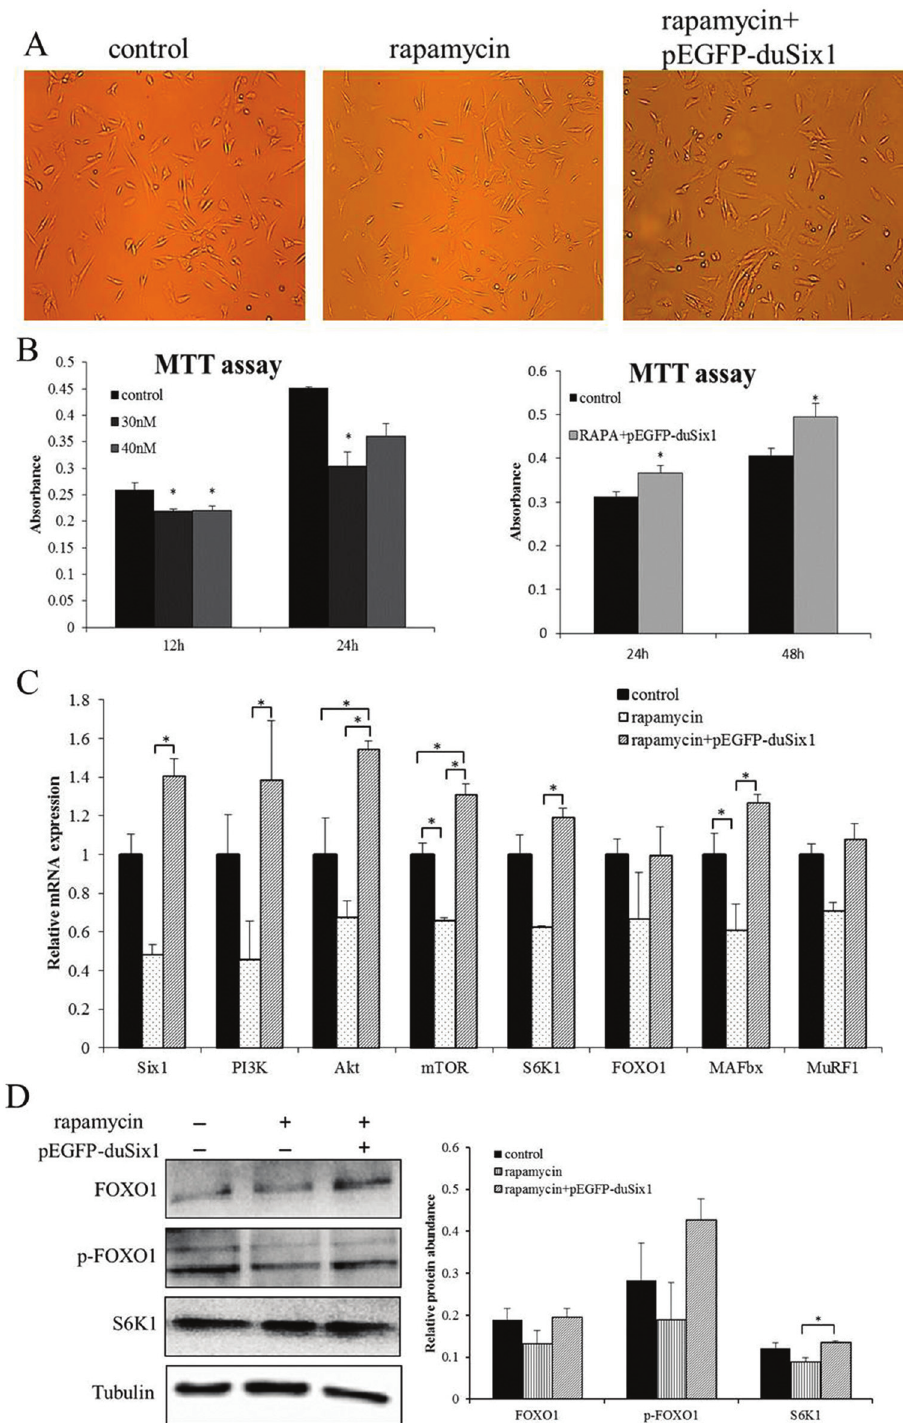
Figure 3 - Overexpression of Six1 can stimulate protein synthesis in rapamycin-treated duck myoblasts. A: Representative images of myoblasts for dif- ferent treatments groups, (a) control cells, (b) rapamycin treatment cells at 24 h, (c) Rapamycin treatment of cells for 24 h was followed by transfection with pEGFP-duSix1 for 48 h. B: Effects of different treatments on cell proliferation of duck myoblasts at different times. Cell proliferation was measured by MTT assay. Absorbance was measured at 570 nm, and data are presented as means (cid:6) SEM, n = 5 wells, *(P < 0.01). C: Relative expression levels of Six1 and key genes related to protein synthesis and degradation in duck myoblasts after different treatments. Duck (cid:2) -actin and GAPDH were used as the internalcontrols.**(P<0.01)and*(P<0.05),valuesaremeans (cid:6) SEM,n=3foreachgroup.D:Westernblotanalysisshowingtheeffectsoftransfection of Six1 on rapamycin treatments in duck myoblasts. Bar graphs showing quantification of the expression level of each protein compared with the expres- sion of tubulin. Data are expressed as means (cid:6) SEM. Western blots are representative of three independent experiments. Western immunoblots probed with antibodies against FOXO1, phospho-FOXO1, S6K1 and tubulin were used as internal